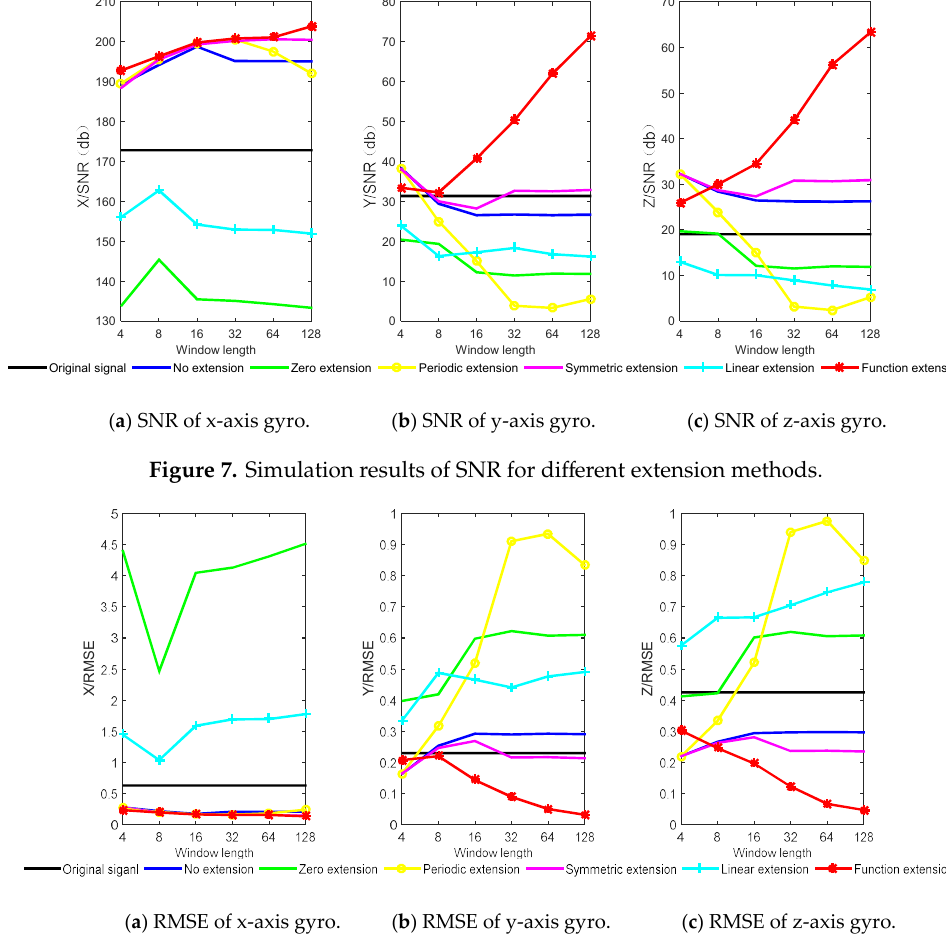
Figure 8. Simulation results of RMSE for different extension methods.